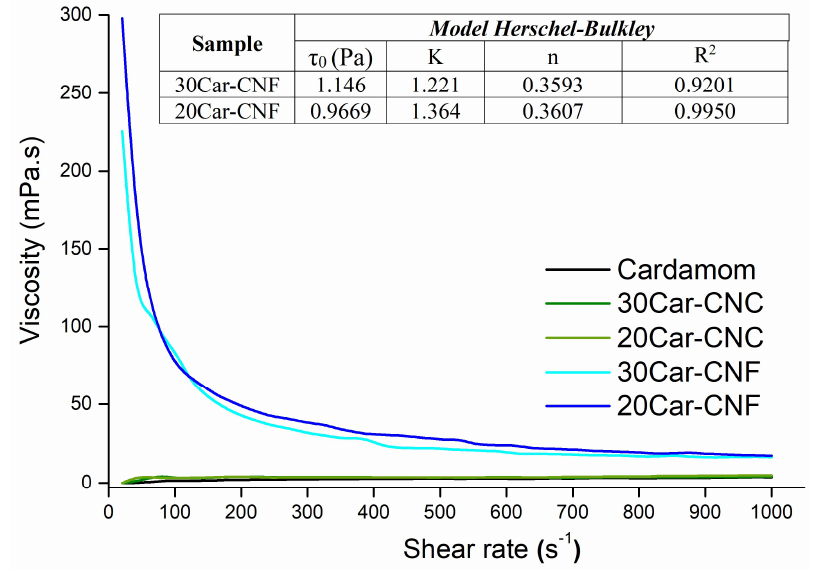
Figure 2. Curves of viscosity versus shear rate of cardamom essential oil and its Pickering emulsions, and the obtained parameters for the Herschel–Bulkley rheological model.